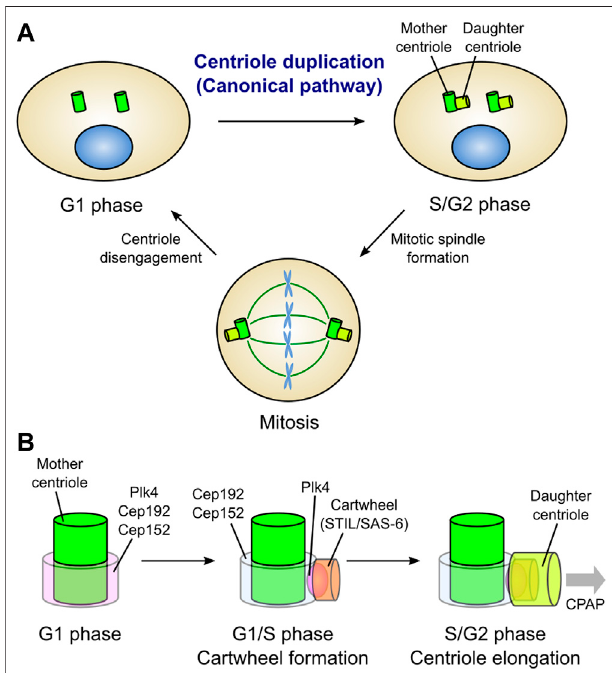
FIGURE 1 | Canonical centriole duplication cycle. (A) Centriole duplication cycle in animal somatic cells. Canonical centriole duplication begins at the G1/S transition. New centrioles (daughter centrioles) are formed from the proximal end of the pre-existing centrioles (mother centrioles). Each pair of mother and daughter centrioles acts as the core of a single centrosome. Twocentrosomes function asbipolar spindle poles in mitosis. At themitoticexit,daughtercentriolesaredisengagedfromthemothercentrioles and convert into functional centrosomes. Thus, just two centrosomes always exist in a cell. (B) Evolutionarily conserved proteins involved in canonical centriole duplication invertebrate cells. IntheG1phase, Plk4, amasterkinase for centriole biogenesis, localizes in a ring-like pattern at the proximal end of the mother centriole along with Cep192 and Cep152, which cooperatively recruit Plk4. At the G1/S transition, Plk4 is re-distributed on a single focus around the mother centriole. Then, Plk4 binds to and phosphorylates STIL, facilitating STIL/SAS-6 interaction. SAS-6 in turn self-assembles to form a cartwheel structure, the basis for centriole assembly, perpendicularly to the mother centriole wall. Following the cartwheel formation, CPAP and other centriolar proteins promote the elongation of the daughter centriole.